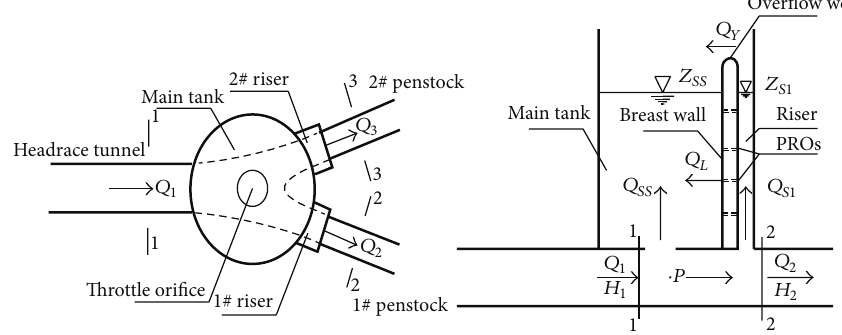
Figure 2: Schematic differential surge tank with PROs and overflow